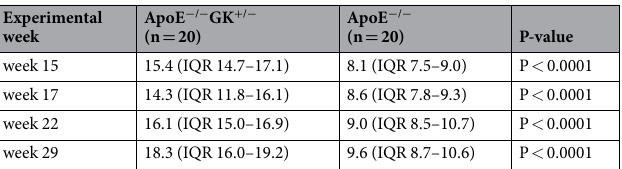
Experimental week